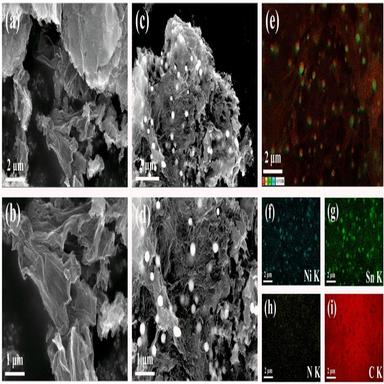
SEM images of the NG (a, b) and Ni3Sn2/NG (c, d). (e-i) The element mappings of the Ni3Sn2/NG.